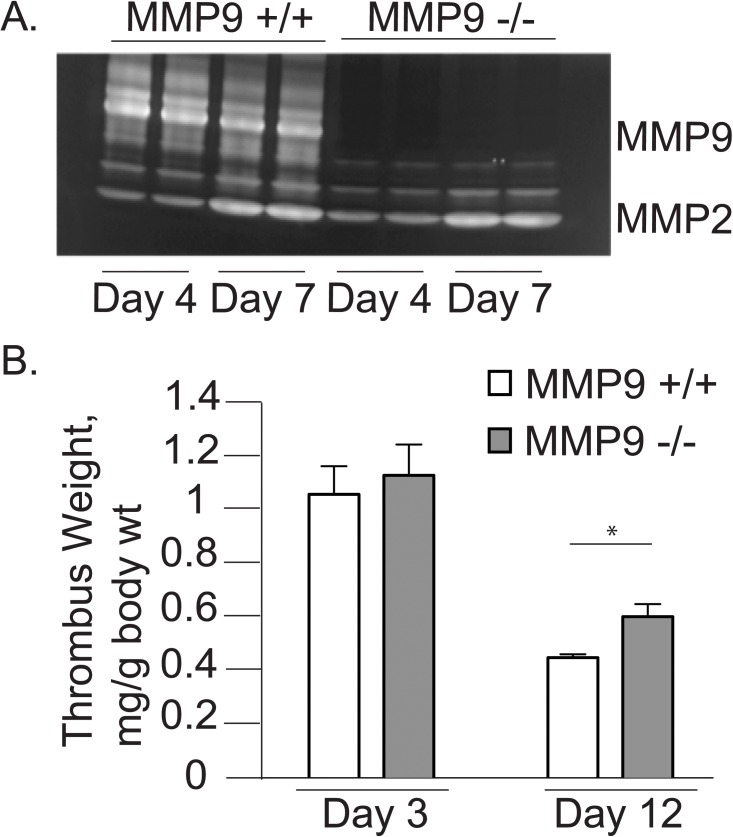
MMP-9 deletion results in impaired thrombus resolution.A. Representative zymograms showing MMP activity in combined thrombus and vein wall samples in MMP-9+/+ and MMP-9-/- mice on day 4 and 7 after IVC ligation (DVT). B. Thrombus weights compared on days 3 (MMP9 +/+ 1.04±0.23 g/kg versus MMP9 -/- 1.11±0.26 g/kg; N = 5 per group, p = 0.67) and 12 (MMP9 +/+ 0.44±0.12 g/kg versus MMP9 -/- 0.56±0.1 g/kg, N = 6 per group; *p<0.05).